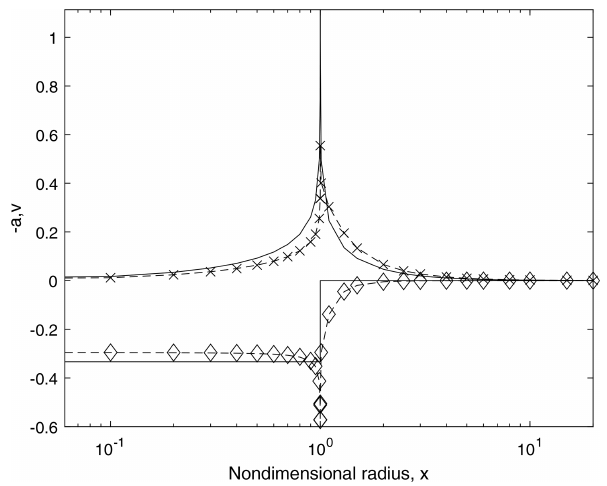
Figure 4. Axial induction, a , and radial velocity, v , for the condi- tions in Table 1. p = 0 . 05: a , (cid:5) ; v , × . The corresponding results for p = 0 . 10 are the dashed lines. Note that − a is shown to make it distinct from v . The solid lines are − a and v for no expansion, i.e. k = 0, R ∞ = 2. The x axis is